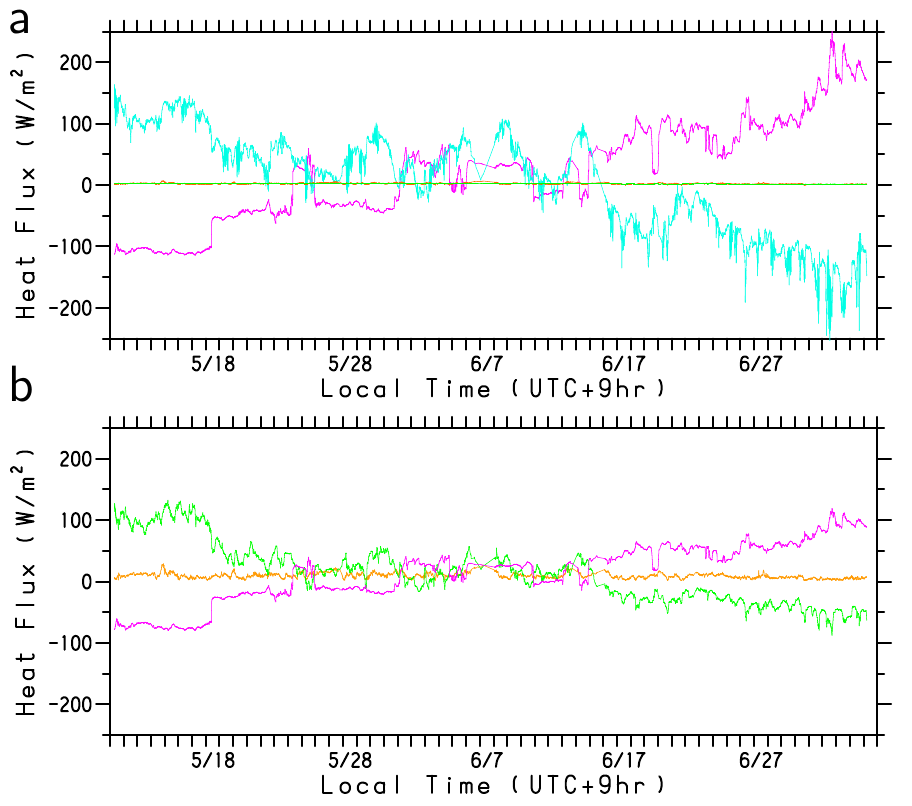
Figure 8. ( a ) LHF and ( b ) SHF variation components (Wm − 2 ) in Equation (1). The components of SST, air temperature, specific humidity, and wind speed are shown by magenta, green, cyan, and orange lines, respectively. Because SHF is independent of specific humidity, the SHF variation due to specific humidity is not plotted in panel ( b ). The abscissa is local time (UTC + 9h) during the observation period from 11 May to 5 July